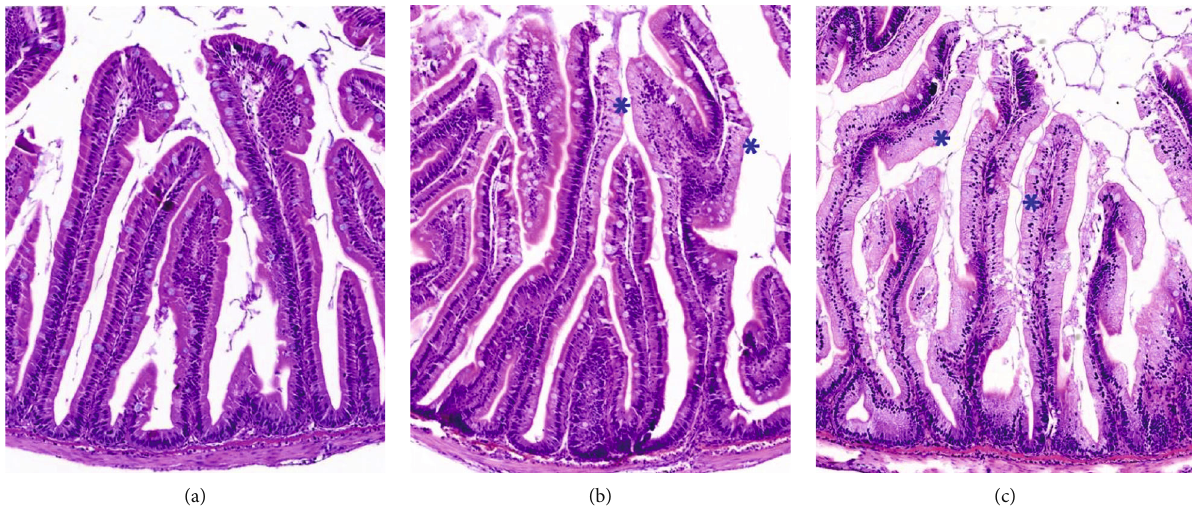
Figure 10: Representative histology images of the pyloric caeca mucosa showing: (a) tissue with normal morphology of pyloric caeca enterocytes with no vacuolization changes; (b) Pyloric caeca tissue with enterocyte steatosis changes graded as moderate and characterized by multifocal areas (blue asterisks) with the lipid vacuolization; and (c) Pyloric caeca with enterocyte steatosis (blue asterisks) a ff ecting almost all the enterocytes and scored as severe in the histology assessment.